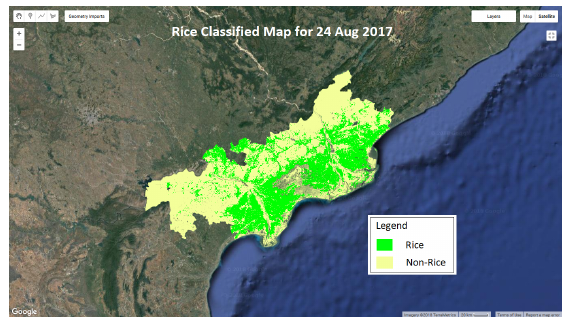
Figure 10. Rice Classified Map for 24 Aug 2017